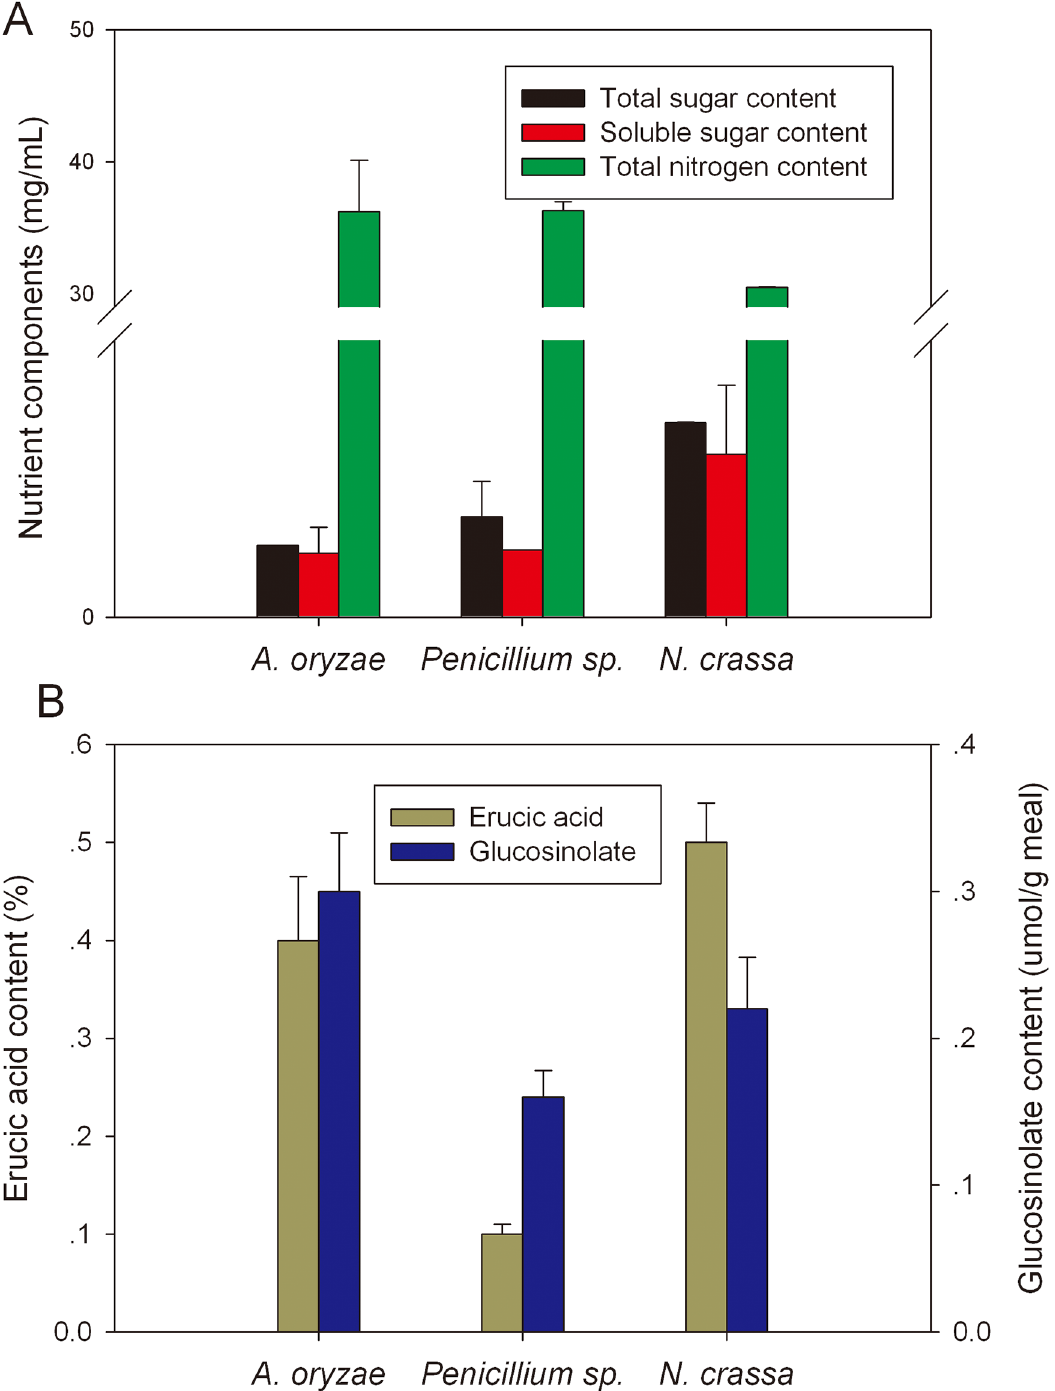
Fig 3. Total nitrogen and sugar contents of the meal hydrolysates. RMHs were obtained by fungal solid state fermentation (pre-treatment) followed by autolysis. Three fungal strains were used for solid state fermentation and autolysis individually. Data are means of three replicates, and error bars show standard